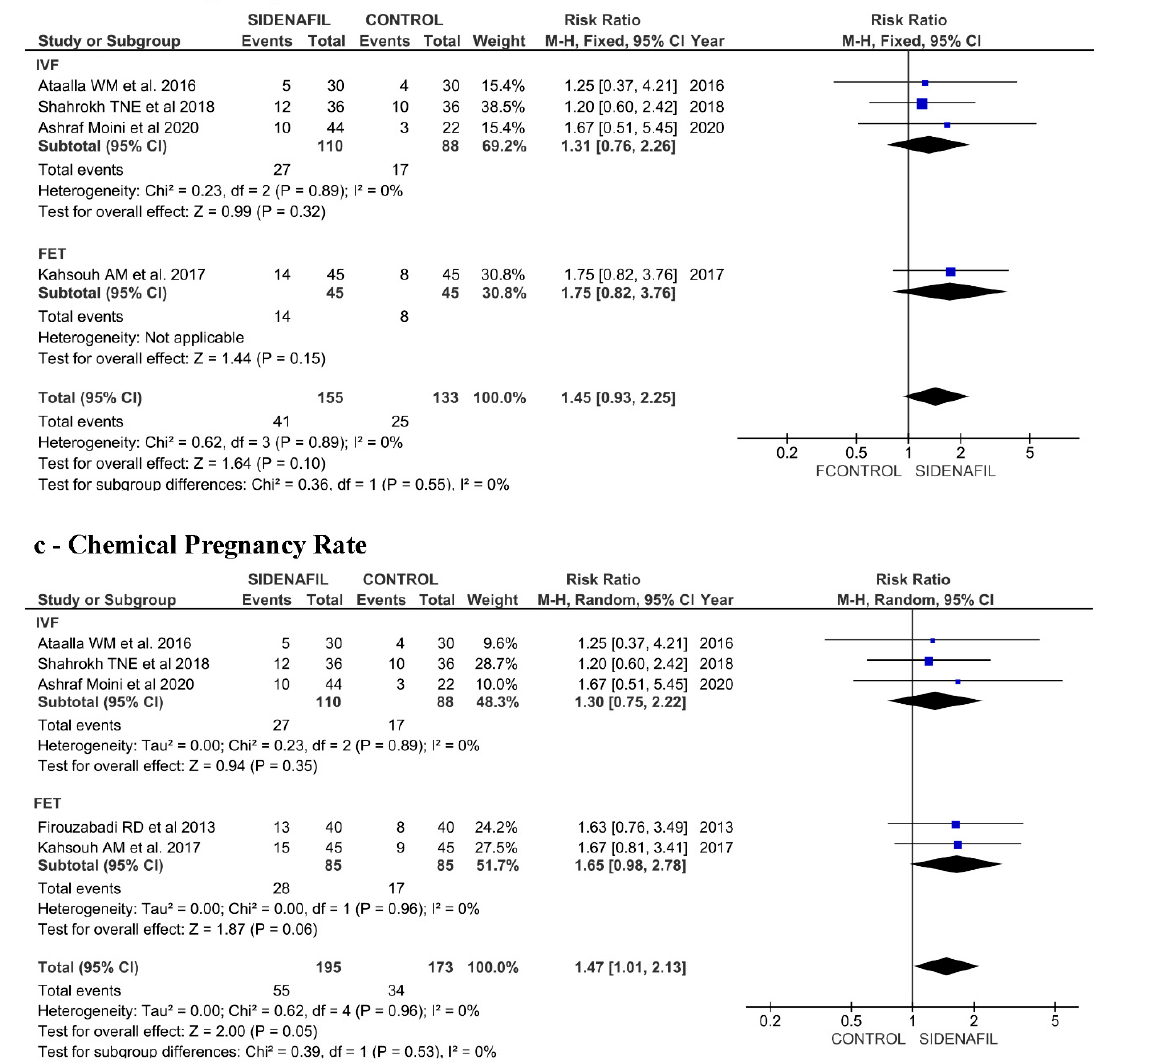
Figure 3. ( a ) Forest plot of comparison: endometrial thickness (ETh) according to group allocation—intervention (Sildenafil) versus control in IVF fresh and frozen embryo transfer. ( b ) Forest plot of comparison: clinical pregnancy rate (CPR) according to group allocation—intervention (Sildenafil) versus control in IVF fresh and frozen embryo transfer. ( c ) Forest plot of comparison: chemical pregnancy rate (ChPR) according to group allocation—intervention (Sildenafil) versus control in IVF fresh and frozen embryo transfer.